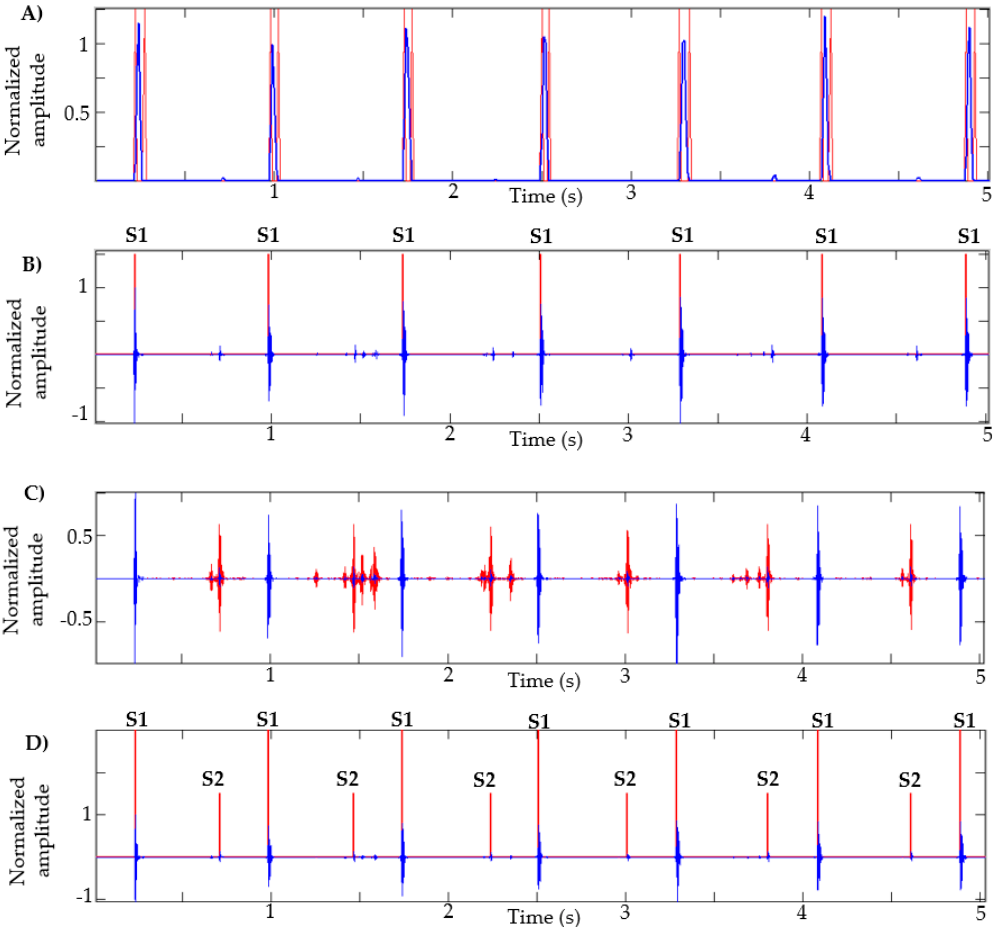
Figure 4. Segmentation of heart sounds with S1 of low amplitude and short duration. ( A ) NASE of heart sound; ( B ) Identification of peaks; ( C ) Heart sound with normalized intervals; ( D ) Identification of S1